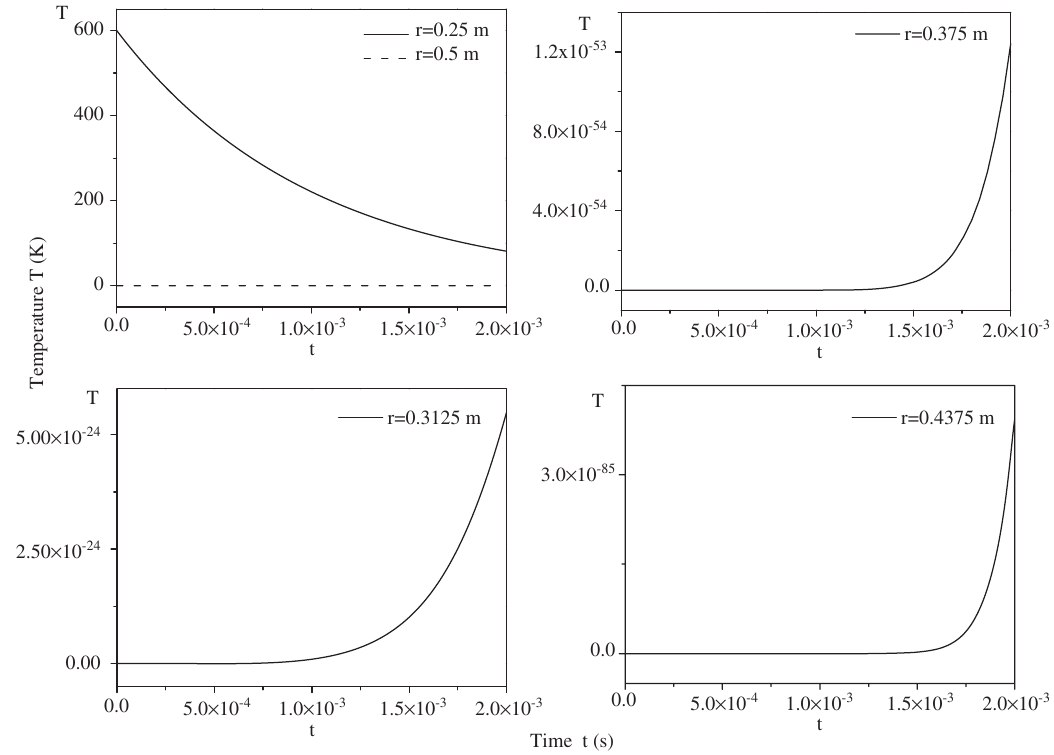
Figure 5 Temperature variation history within the FGM hollow cylinder, where n = 1.